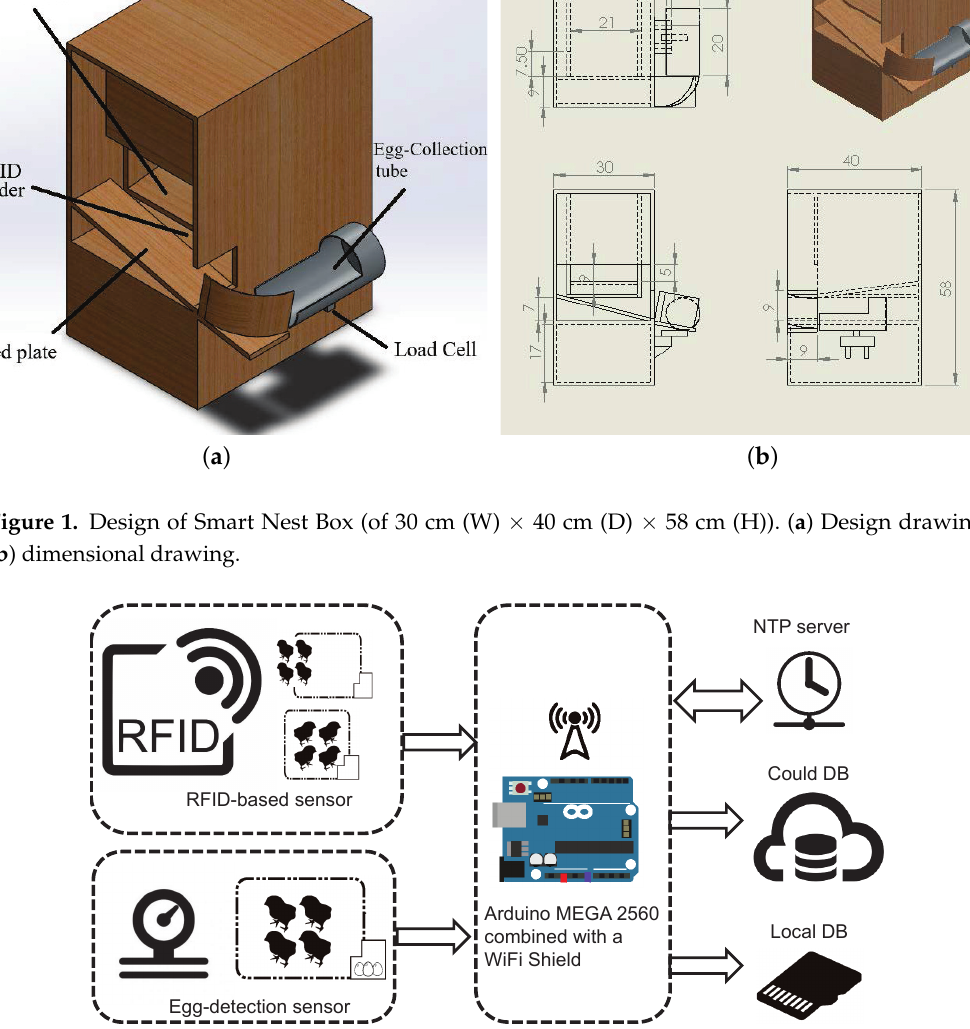
Figure 2. Block diagram of our IoT